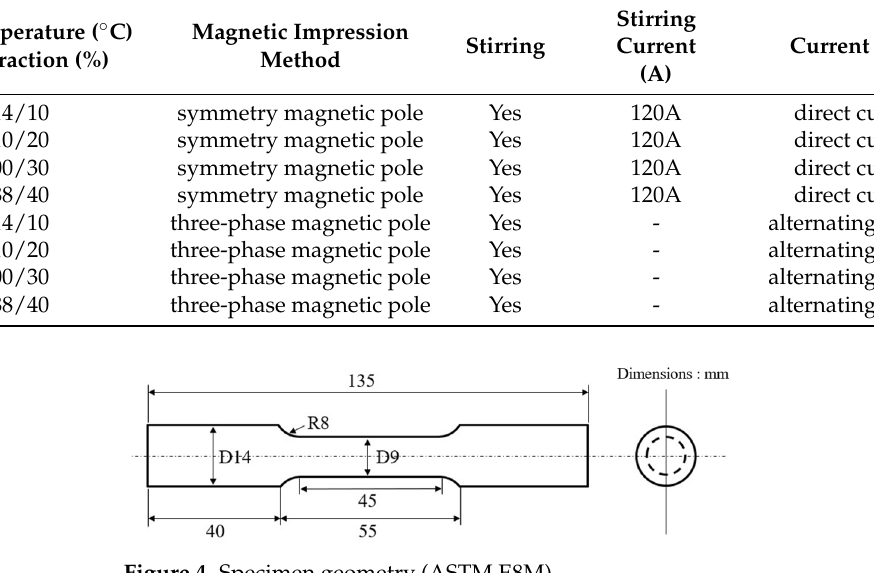
Figure 4. Specimen geometry (ASTM E8M).